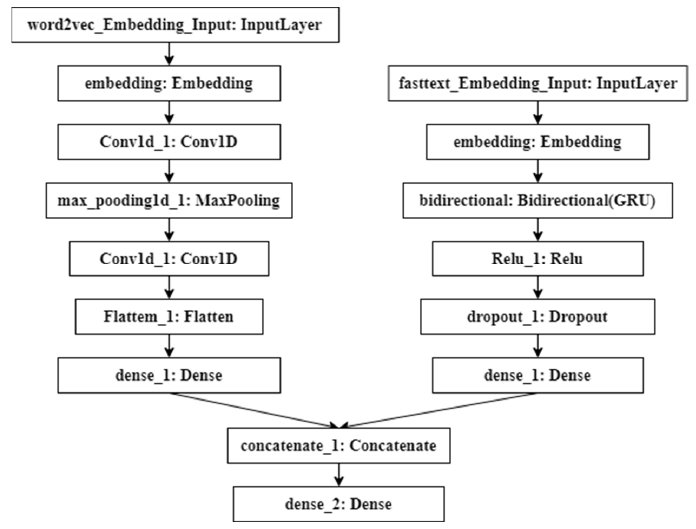
Figure 7. CBGRU layer structure.